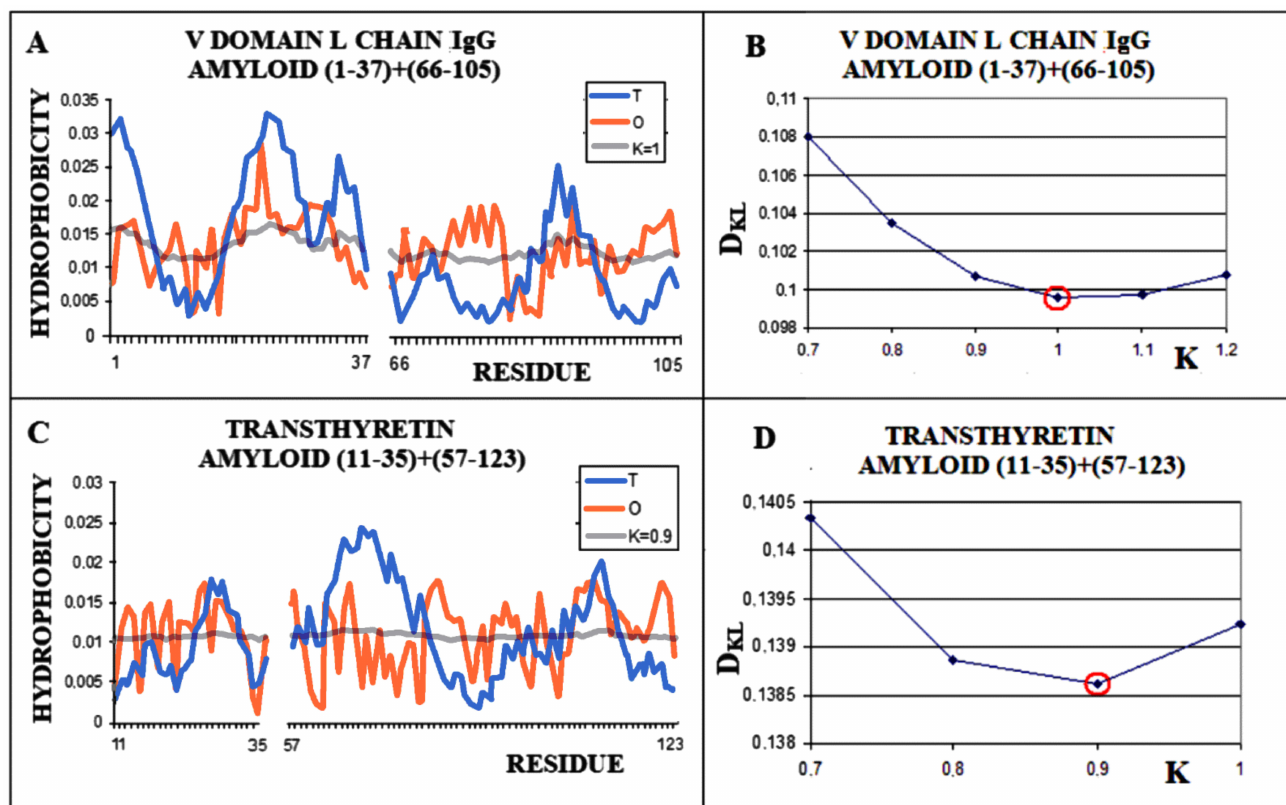
Figure 5. Characteristics of amyloid forms: ( A )—Distributions of T-navy blue, O-red, and M-gray for a single-chain as appeared in amyloid form. ( B )—Change in the D KL value for the O–M relation with different values of the K parameter. The lowest value was indicated as representing the shortest distance between the O and M distribution. ( C )—Profiles of T-navy blue, O-red, and M-gray for a single-chain structure of transthyretin in the form present in amyloid. The M distribution is obtained for the parameter K = 0.9. ( D )—Change in the D KL value for the O–M relation with different values of the K parameter. The lowest value was indicated as representing the shortest distance between the O and M